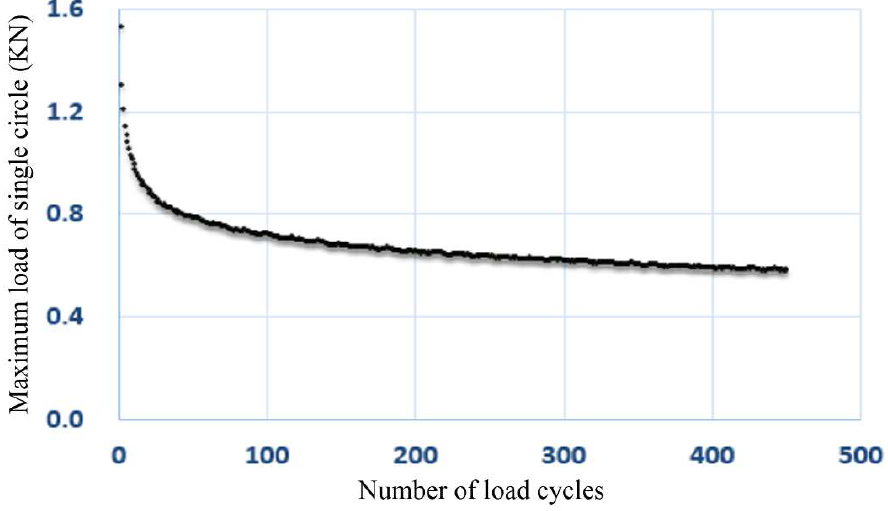
Figure 8. The relationship between the maximum load of a single circle and the number of load cycles.